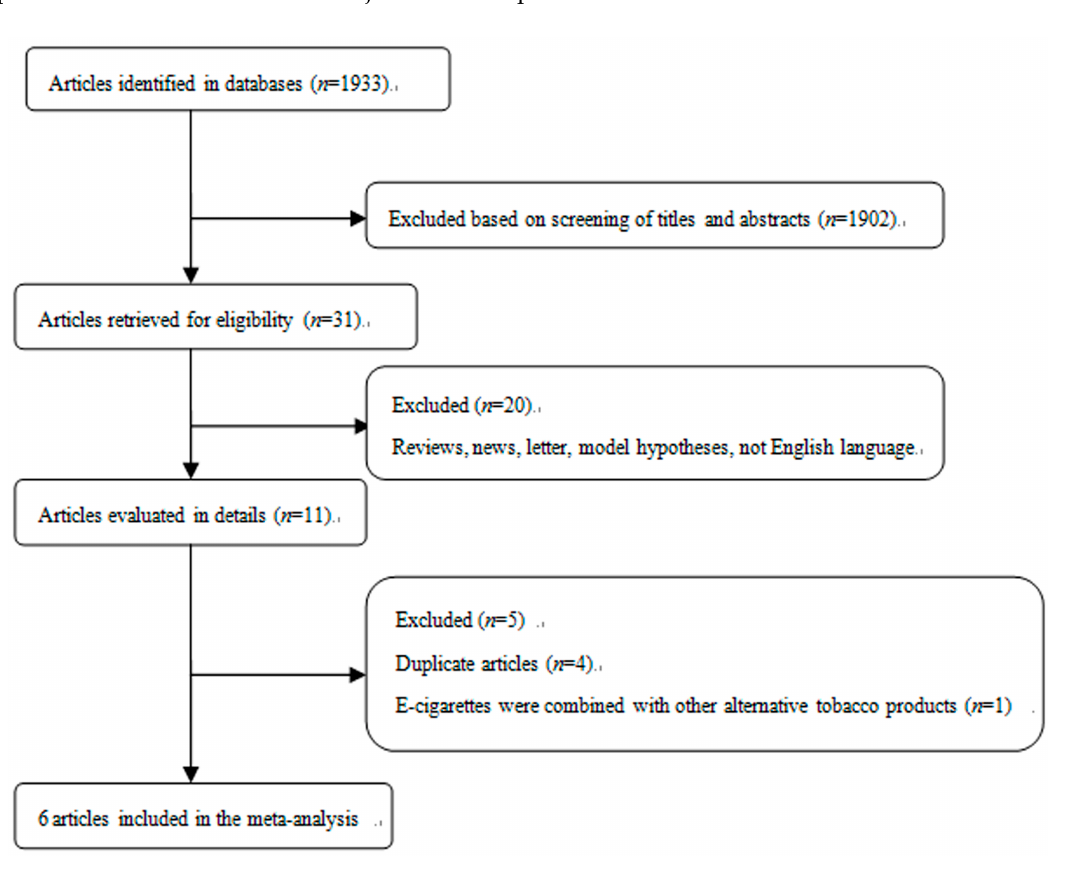
Figure 1. Selection of studies for inclusion in meta-analysis.